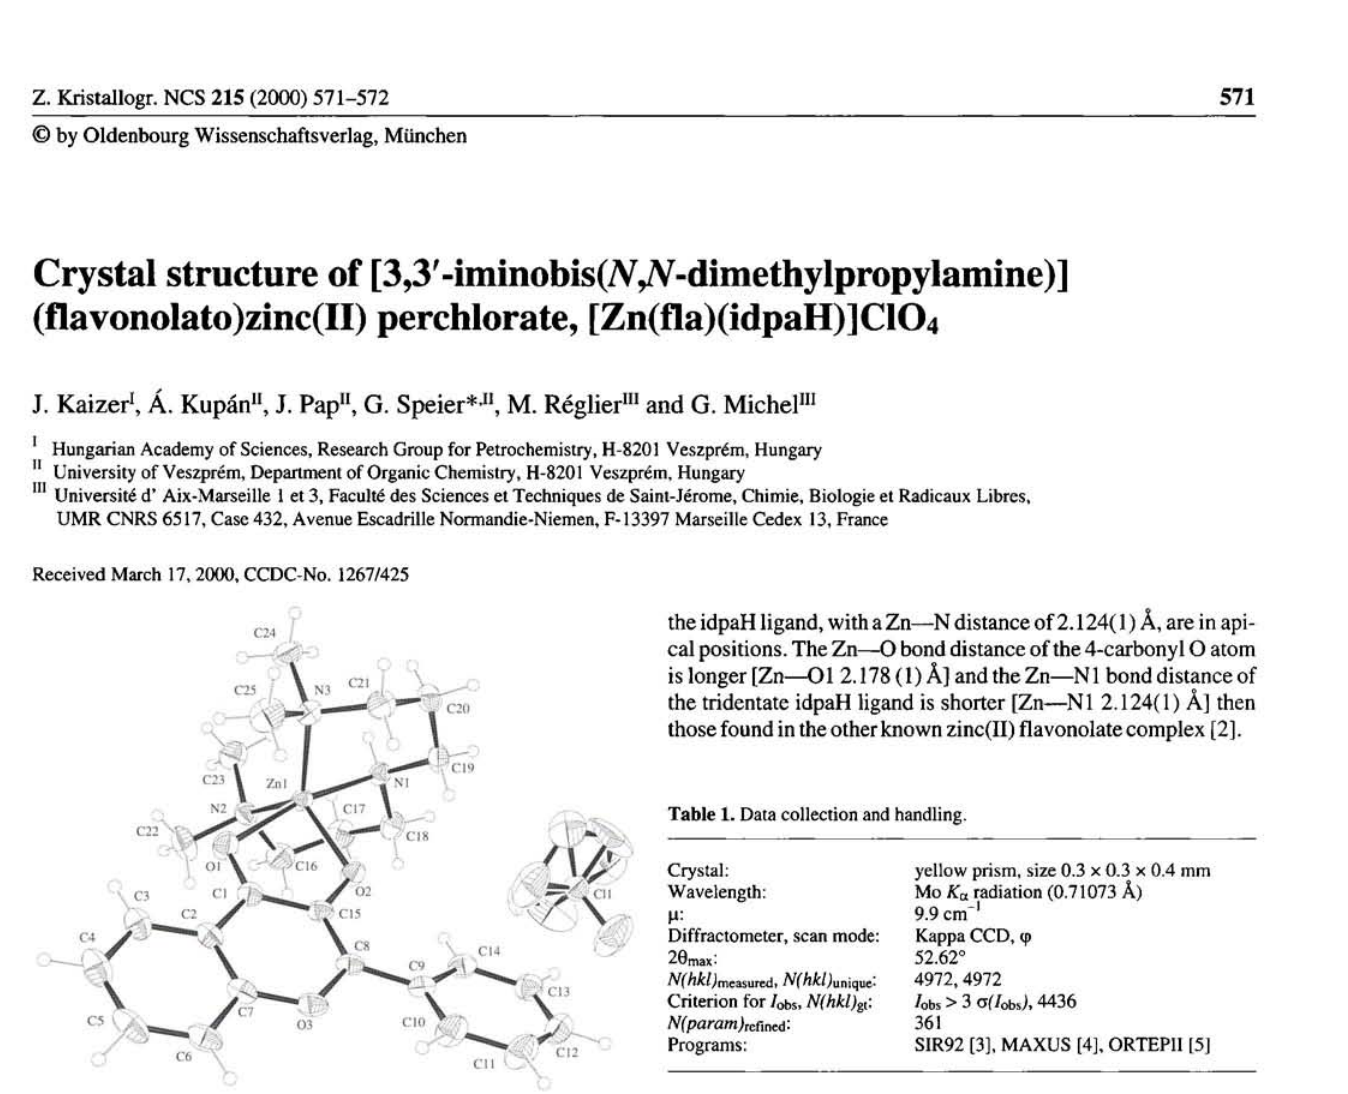
Table 2. Atomic coordinates and displacement parameters (in Â 2